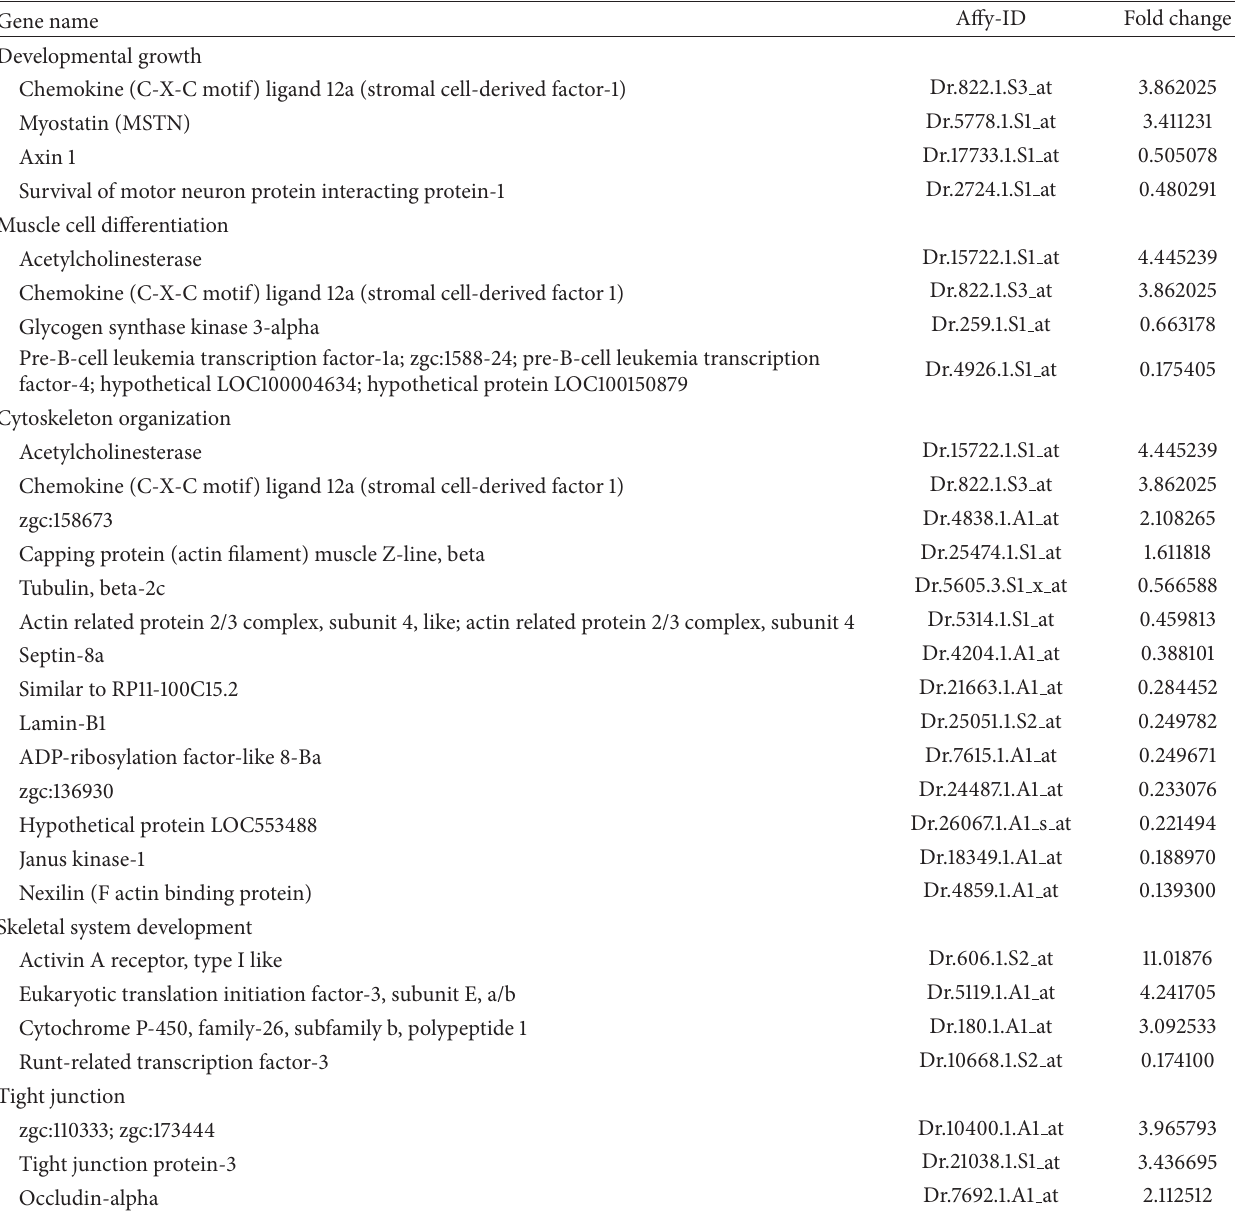
Table 3: Differentially expressed genes involved in muscle development and growth in the muscle of crisp grass carp and grass